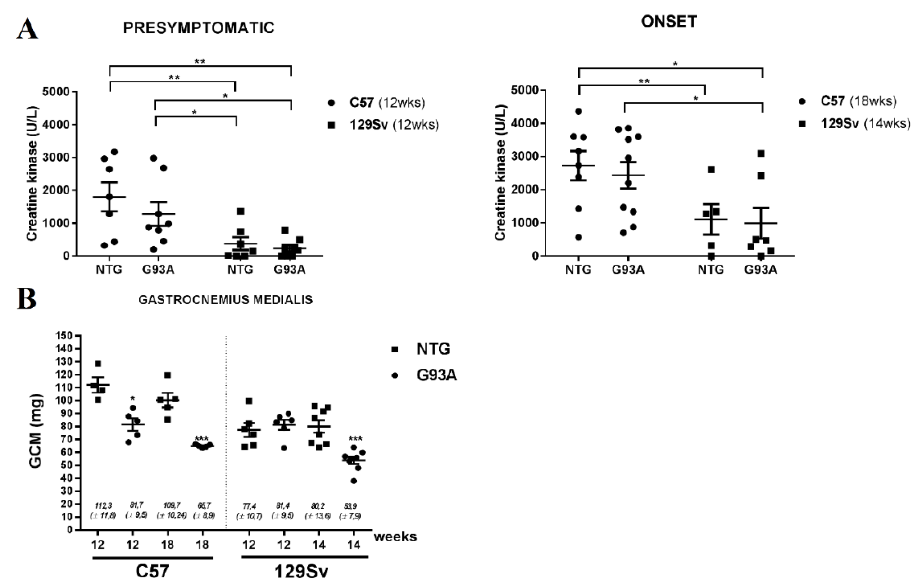
Figure 4. CK serum levels (U / L) in slow and fast progressive ALS mice. ( A ) CK levels were measured in mouse serum of C57-SOD1G93A (slow), 129Sv-SOD1G93A (fast), mice and relative controls (NTG) at pre-symptomatic (12 weeks) and onset (18 and 14weeks respectively) disease stages. CK levels were significantly higher in C57 mice than 129Sv mice, regardless of SOD1G93A mutation. Statistical significance was calculated by Two-Way ANOVA with Sidak’s post-analysis. Data are presented as mean ± SEM. * p < 0.05; ** p < 0.001. ( B ) Muscle wasting was calculated by measuring of the gastrocnemius medialis (GCM) muscle weight of C57-SOD1G93A and 129Sv-SOD1G93A mice and relative NTG littermates. Statistical significance was calculated by Mann and Whitney test. Data are presented as mean ± SEM. * p < 0.05; *** p < 0.0001.